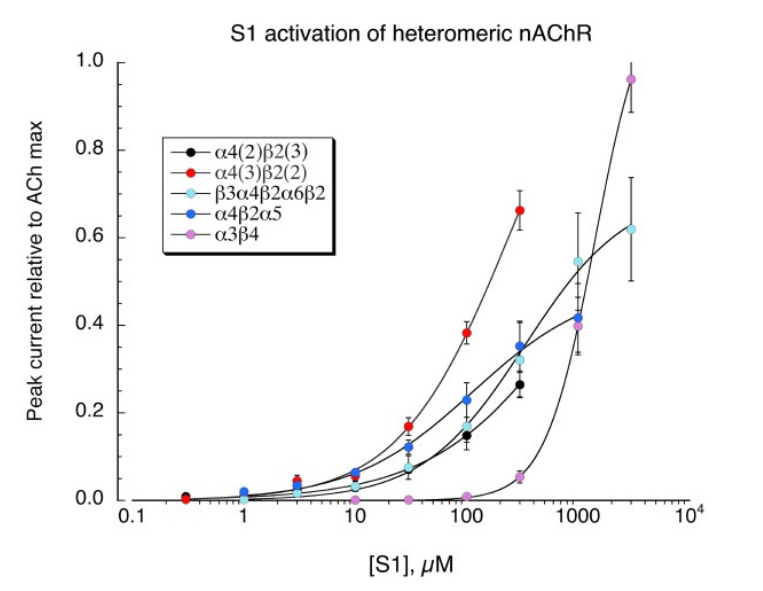
Figure 6. Activation of heteromeric neuronal nAChR by S1 . Concatamers were used in order to obtain receptors with known subunit composition. The β 2-6- α 4 concatamer was co-expressed with monomeric α 4, β 2, or α 5 to obtain receptors with the composition α 4(3) β 2(2), α 4(2) β 2(3), or α 4(2) β 2(2) α 5, respectively. A concatamer of five linked subunits was used to obtain the β 3 α 4 β 2 α 6 β 2 receptors. The α 3 β 4 receptors were formed from the co-expression of α 3 and β 4 subunit monomers at equal ratios. Data are the average peak currents (n = 6–8 oocytes ± SEM), measured relative to initial ACh control responses for each oocyte (concentrations listed in Methods). Responses were subsequently adjusted for the relative values of the ACh controls and the ACh maximum responses for each of the various subtypes, determined in previous experiments. Curve-fit values are provided in Table